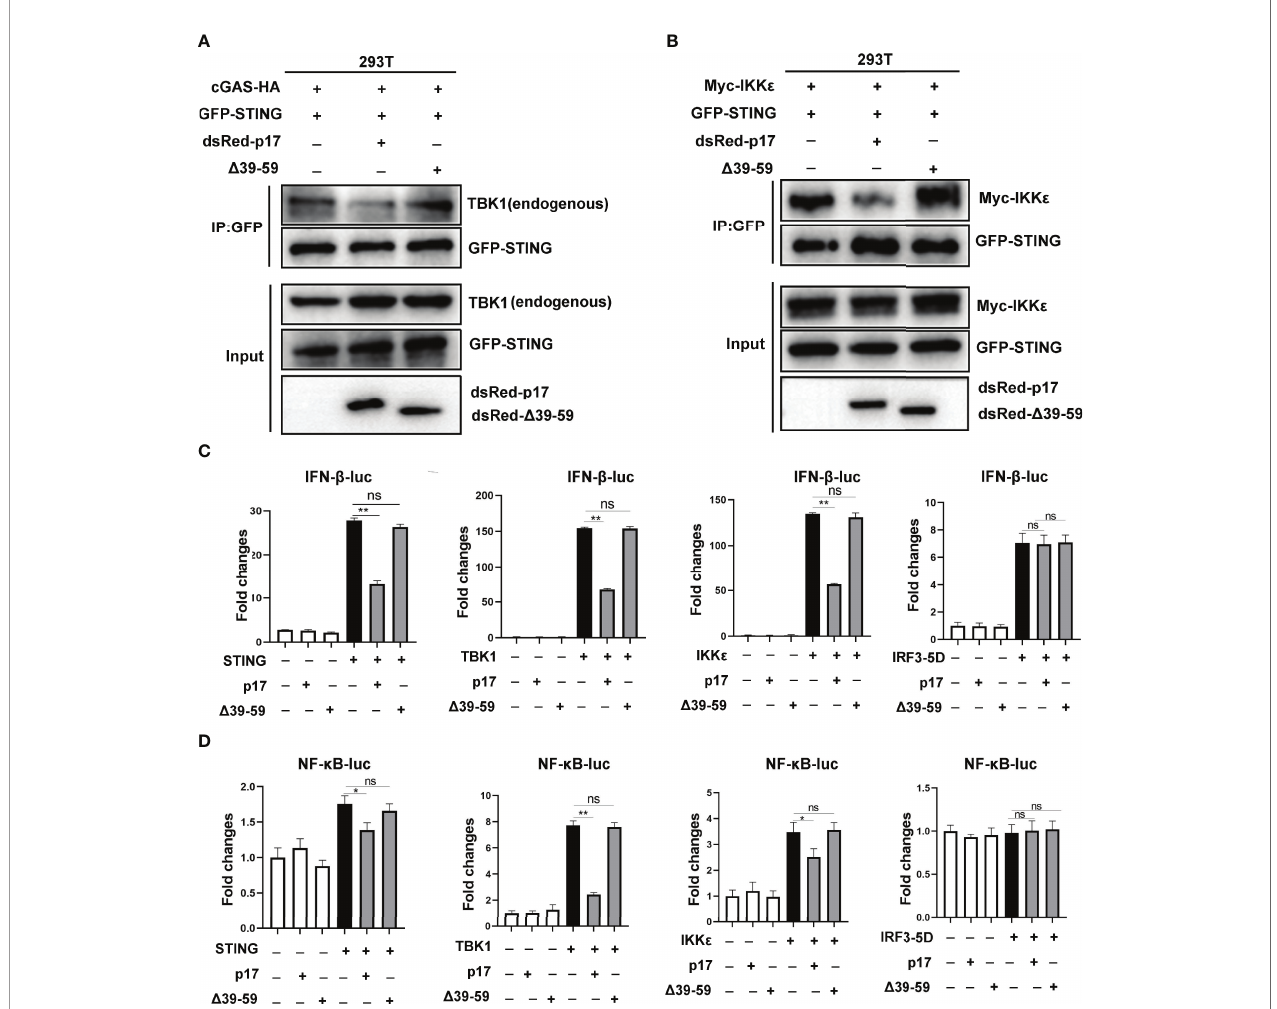
FIGURE 8 | (A, B) The effect of p17 △ 39-59 on the binding between STING and TBK1/IKK ϵ . (A) 293T cells in 6 well plate (6-8×10 5 cells/well) were transfected with cGAS-HA (0.5 m g) and GFP-STING (0.5 m g) plus dsRed-p17 (0.5 m g) or △ 39-59 (0.5 m g) for 24h. (B) 293T cells were transfected with GFP-STING (0.5 m g) and Myc-IKK ϵ (0.5 m g) plus dsRed-p17 (0.5 m g) or △ 39-59 (0.5 m g) for 24h. The effect of p17 △ 39-59 on the binding between STING and TBK1/IKK ϵ was analyzed by Co-IP and Western blotting using the indicated antibodies. (C, D) The effects of p17 △ 39-59 on the activations of IFN- b (C) and NF- k B (D) promoter triggered by STING (20 ng), TBK1 (20 ng), IKK ϵ (20 ng) and IRF3-5D (20 ng) were examined using dual-luciferase reporter assay. Values represent the mean±S.D. * P <0.05, ** P <0.01, ns not signi fi